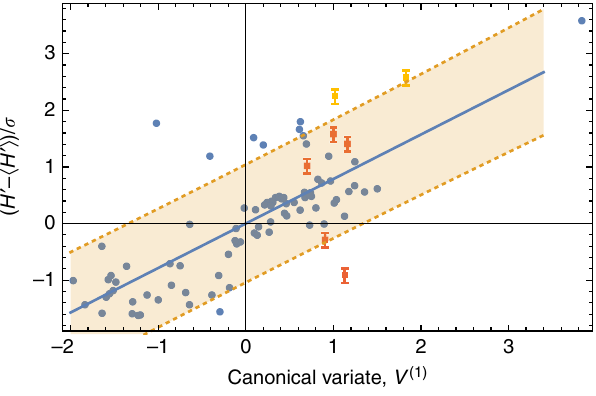
Fig. 3 Correlation analysis. The canonical variate, V (1) , versus the canonical variate, W (1) = ( H ' − 〈 H ′ 〉 )/ σ , for each alloy (blue circle) and the corresponding regression line (solid blue). The Vicker ’ s hardness is H and σ denotes the standard deviation in normalized hardness. The dotted lines delimit a shaded 90% (single observation) prediction band. Also shown are the measured (normalized) micro-hardnesses for 7 fabricated alloys (5 orange squares, with the 2 alloys having hardnesses in excess of 1000 hardness values (HV) in yellow.) The error bars were estimated from approximately 20 separate hardness measurements per sample.